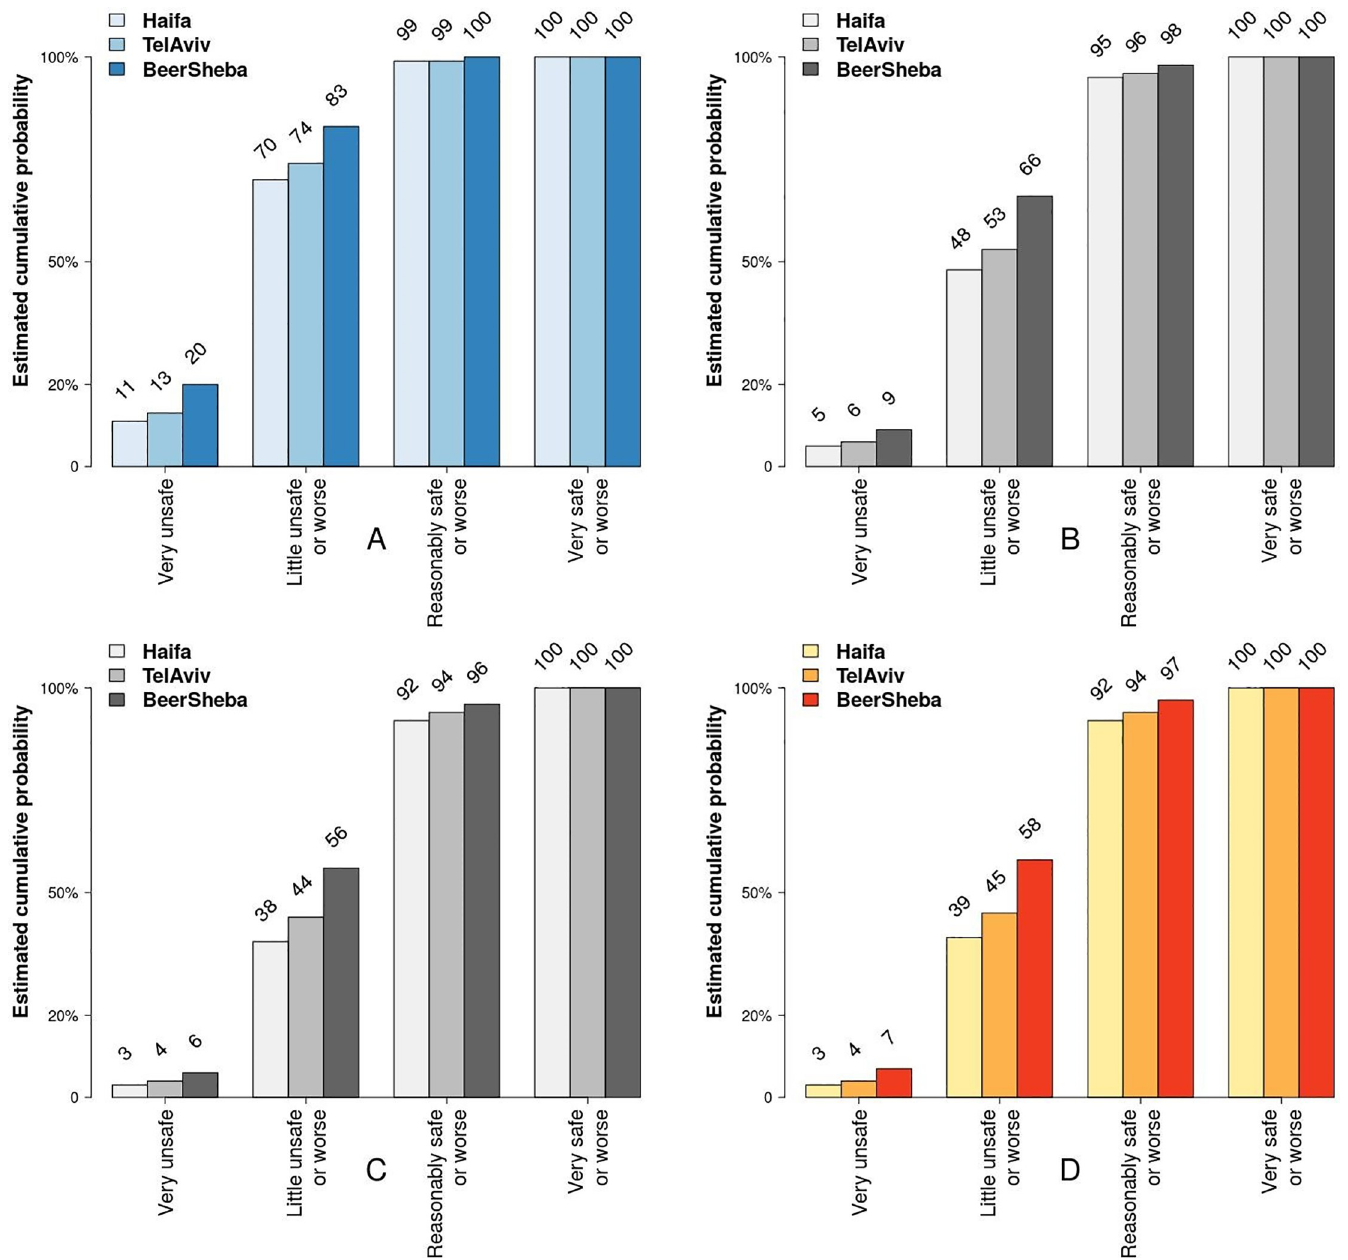
Fig 7. Cumulative probability estimates of FoS assessments for different cities and different light color temperatures (a model response test). Light temperature: A = too cold; B = a bit cold; C = a bit hot; D = too hot. Note: The estimates are based on Model 2 in Table 4 and are generated by changing light color temperature levels only, while holding the values of all other variables constant and equal to 1 on a 4-point Likert scale (from 0 (Low) to 3